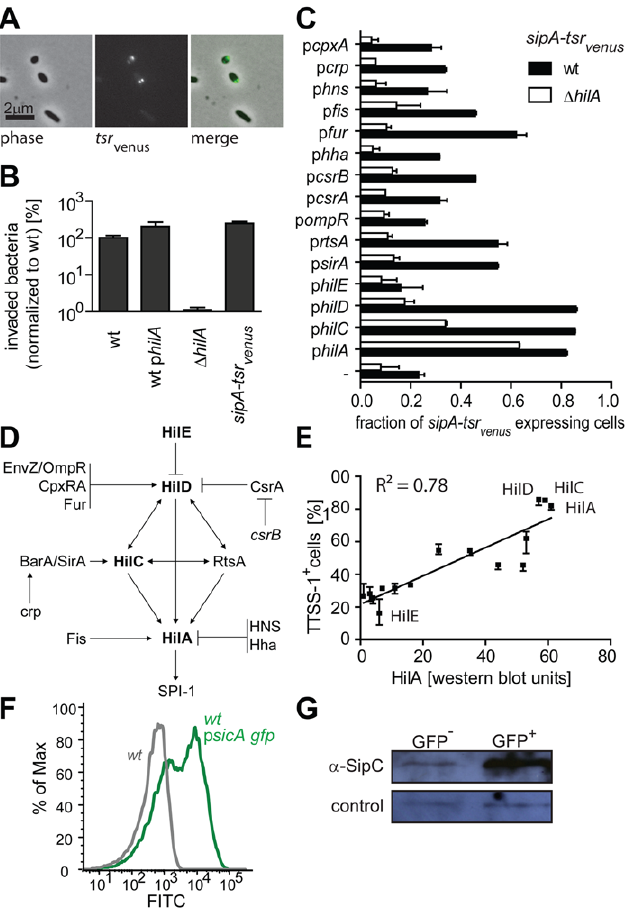
Figure 1. sipA - tsr venus as a single cell reporter for ttss-1 expression. A) Bistable expression of sipA - tsr venus in wt S . Tm (M2001). Living bacteria (4 h in LB) were imaged by fluorescence- and phase contrast microscopy. Bar, 2 m m; B) Invasion into MDCK cells (3 indep. experiments; 6 s.d.; Materials and Methods). C) Response of the sipA - tsr venus reporter to over-expression of known ttss-1 regulators. Wt S . Tm ( sipA - tsr venus ; M2001; black bars) or D hilA ( sipA - tsr venus ; M2018; open bars) harboring the indicated regulator-expression plasmids (Table S2) were cultured for 4 h in LB and FACS- analyzed (triplicates 6 s.d.). D) ttss-1 regulation cascade depicting the regulators analyzed in C) and E; adapted from [35,36,59,60,61,62]). E) Correlation between HilA protein levels and the fraction of ttss-1 expressing individuals. The fraction of cells with the TTSS-1 + phenotype (from C) was plotted against the average HilA expression (average of $ 3 independent quantitative Western blots per regulator and strain). F) Bistable expression of psicA- gfp in S . Tm SL1344 determined and separated by FACS; G) Western blot analysis of TTSS-1 - and TTSS-1 + subpopulations from F) using a polyclonal rabbit a -SipC antibody.